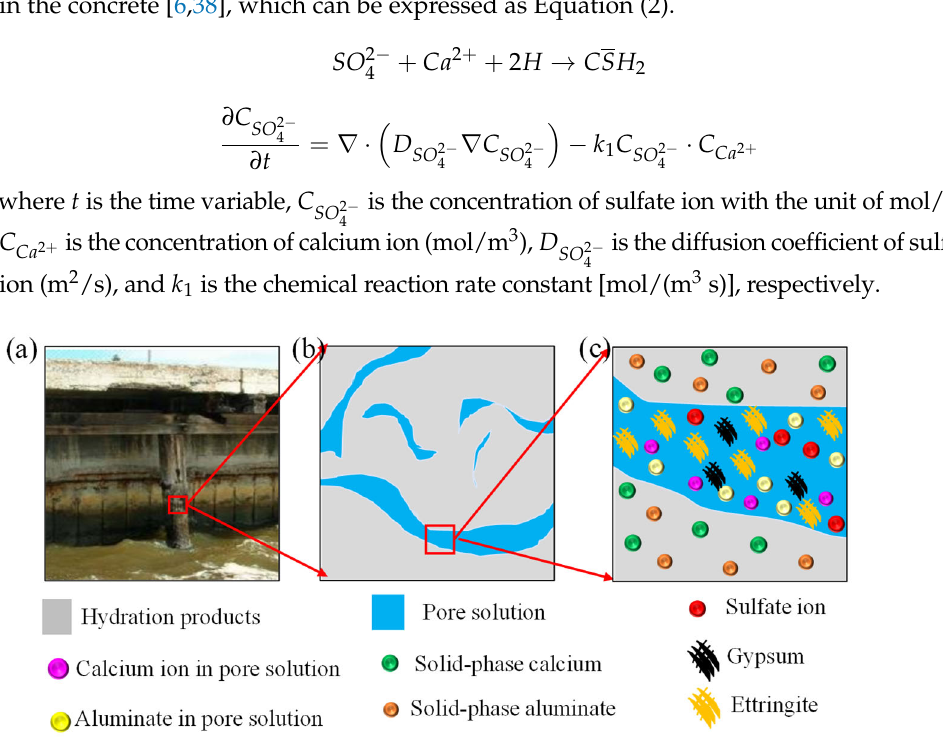
Figure 1. ( a ) Concrete columns in sulfate environment, ( b ) concrete meso-structure, and ( c ) local magnification of concrete meso-structure, respectively.